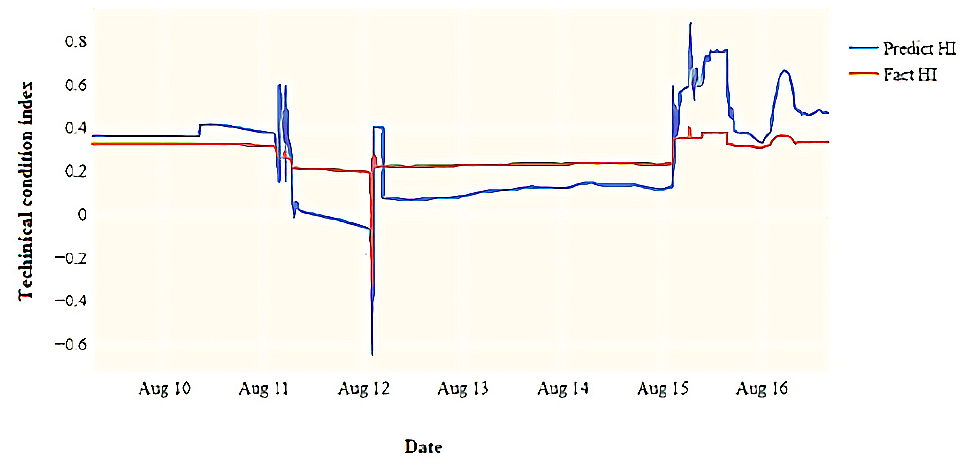
Figure 8. Changes in the predicted values of the technical condition index on the test set in comparison with real data (time shift—10 h).